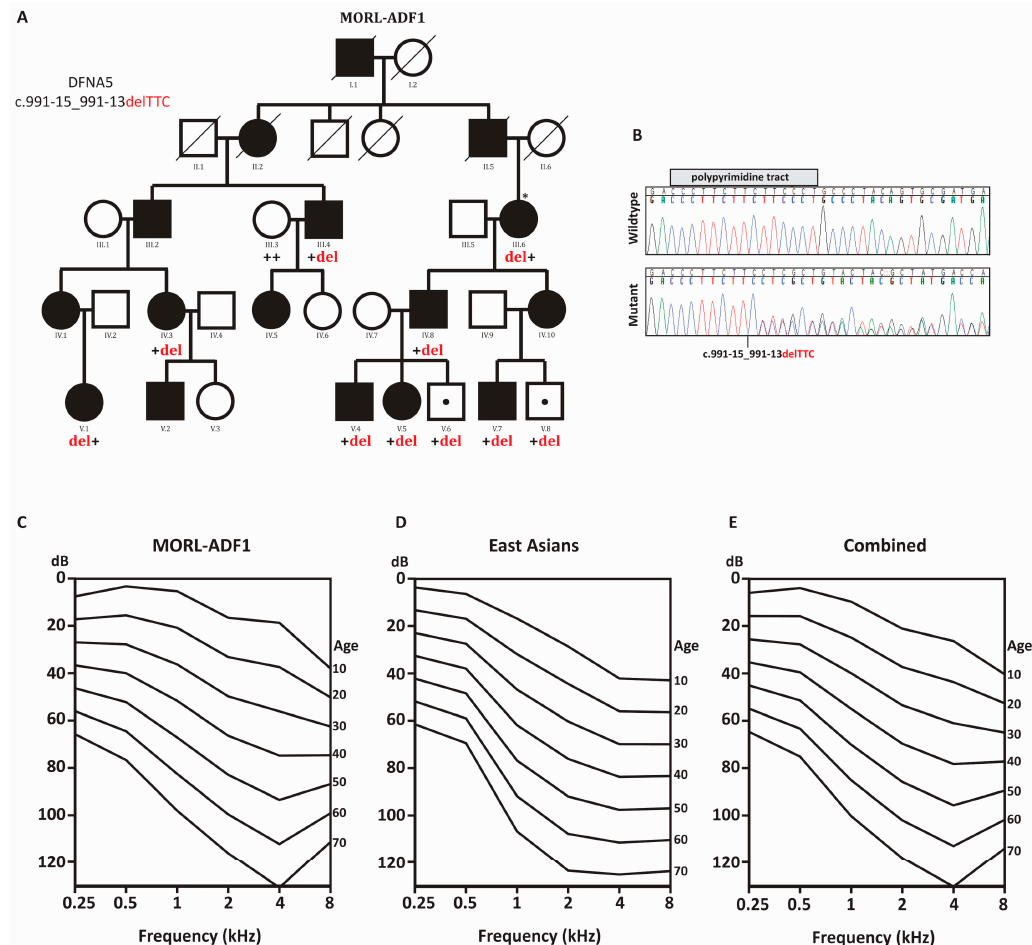
Figure 1. Segregation of the c.991-15_991-13delTTC in DFNA5 and its related age-related typical